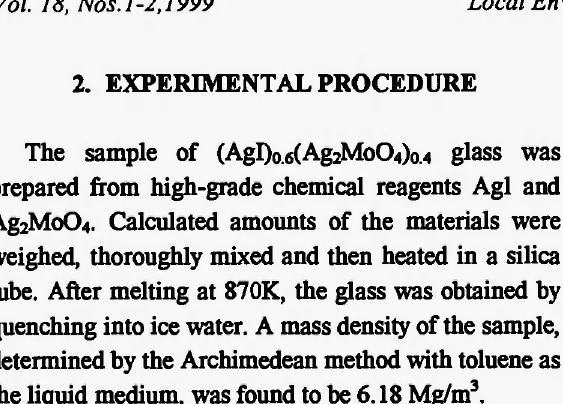
Mo AT-absorption edge